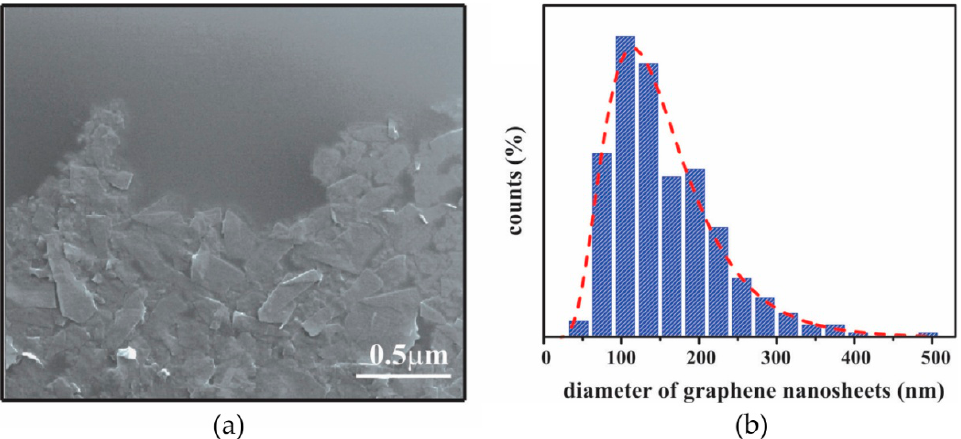
Figure 5. ( a ) SEM image of graphene film; ( b ) Histograms of lateral size of graphene nanosheets obtained from six 3 × 3 µm 2 SEM images (~1800 flakes); The red dashed line represents a log-normal fit.